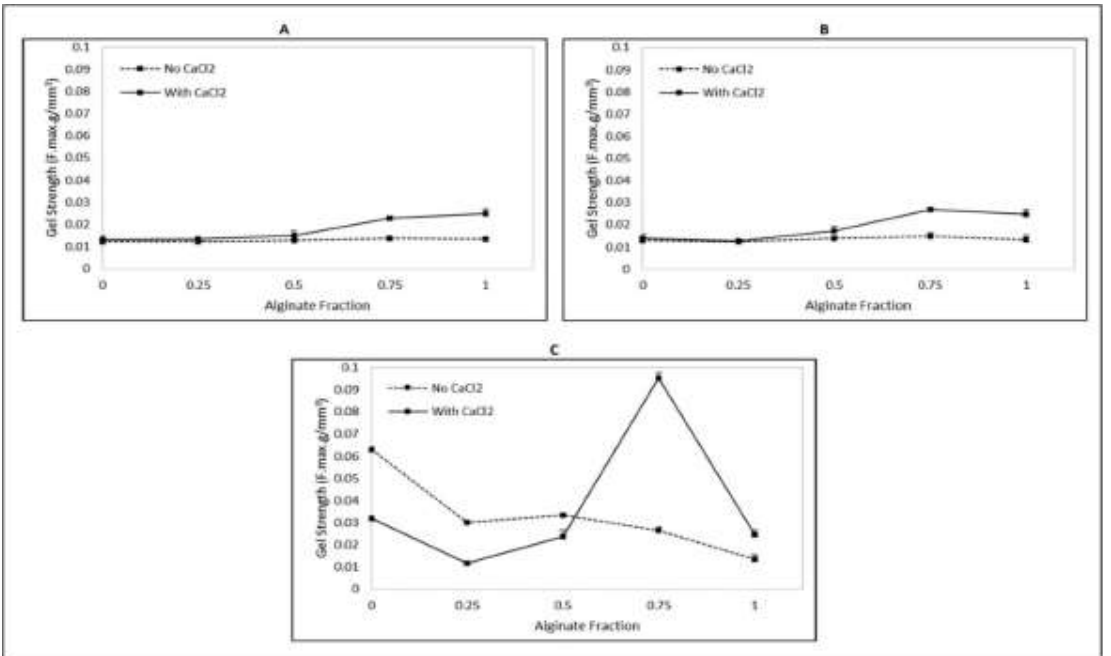
Figure 3. The gel strength of mixture solution of alginate with gum acacia/pectin/carrageenan. a: alginate with gum acacia; b: alginate with pectin; and c: alginate with carrageenan. data shown are the average values and standard deviation (n=2).